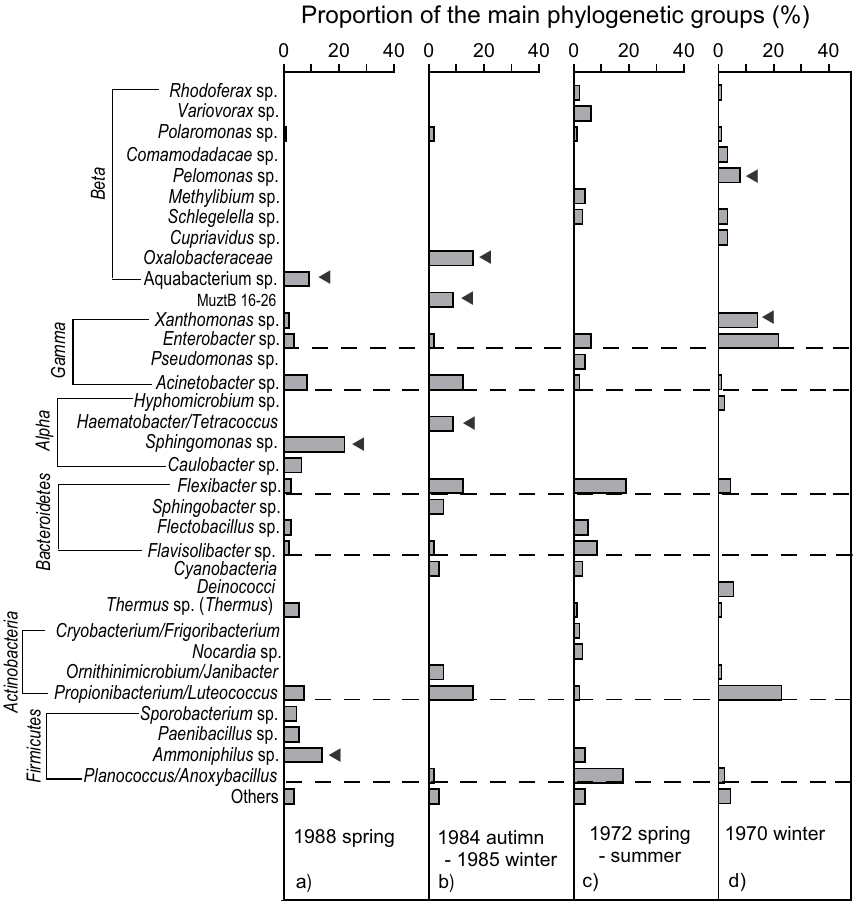
Fig. 4. Proportion of the main phylogenetic clusters (genera) based on the Blast result of 16S rRNA gene sequences in each of the clone libraries in the different ice layers along the MuztB ice core profile: (a) MuztB13, (b) MuztB16, (c) MuztB28, and (d) MuztB30. Alph , Beta , and Gamma = Alpha -, Beta -, and Gamma-proteobacteria